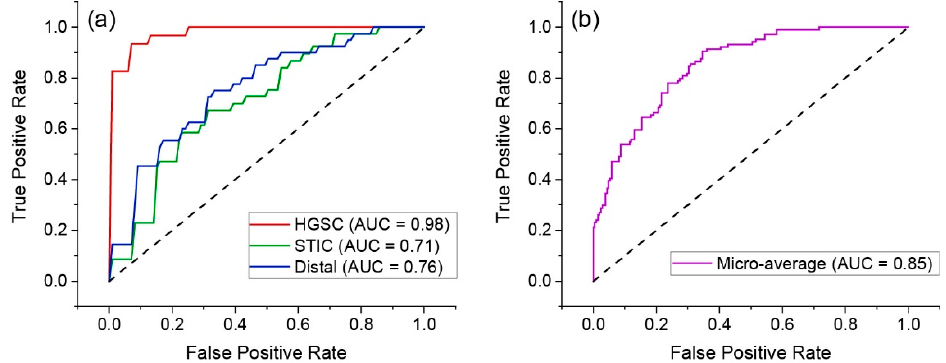
Figure 7. The canonical variables resulting from the CANDISC procedure using 24 ( a ) and 12 ( b )variables. The results of the DISCRIM procedure are given in the accompanying table. Solid and dashed circles are 95% and 80% confidences, respectively. The full set of 24 metrics performed better than the reduced set of 12.